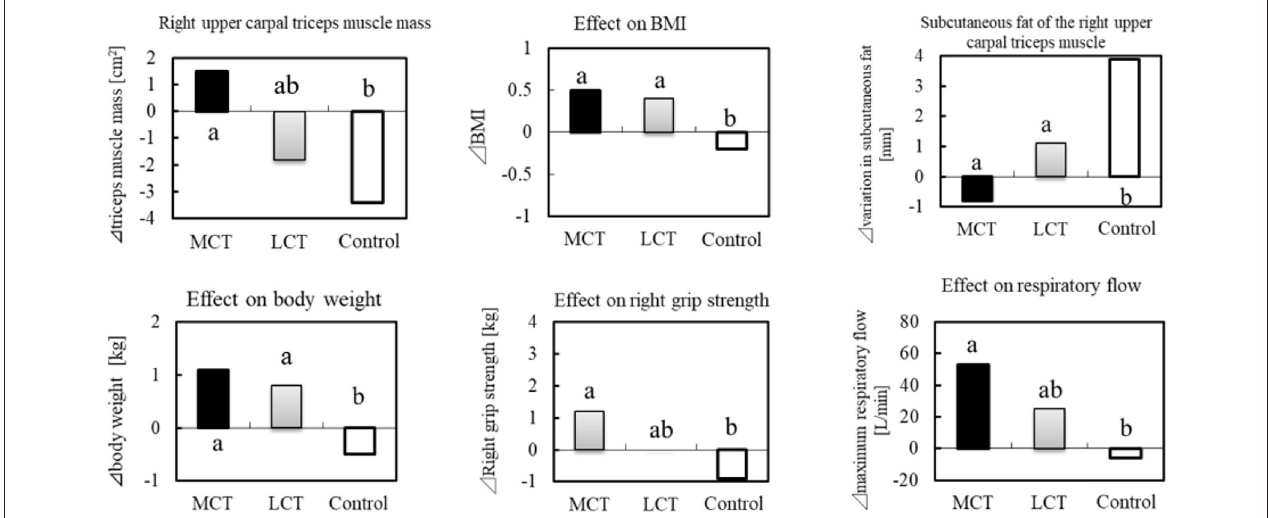
FIGURE 4 | BMI, muscle mass and sarcopenia prevention in the elderly by MCTs ingestion. Thirty-six elderly residents were given MCTs at mealtime (6 g/day for 90 days). In addition, BCAA (1.2g) and vitamin D (800IU) were commonly ingested in the MCT group, LCT group at the same time.